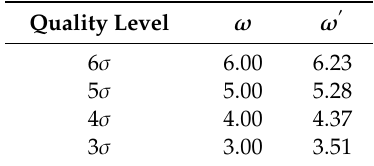
Table 2. Comparison of quality levels for ω and ω (cid:48)